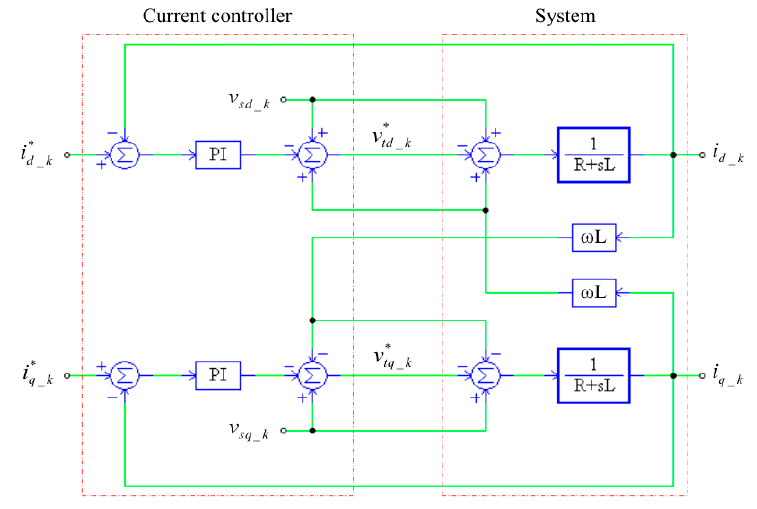
Figure 6. Control diagram of the current .